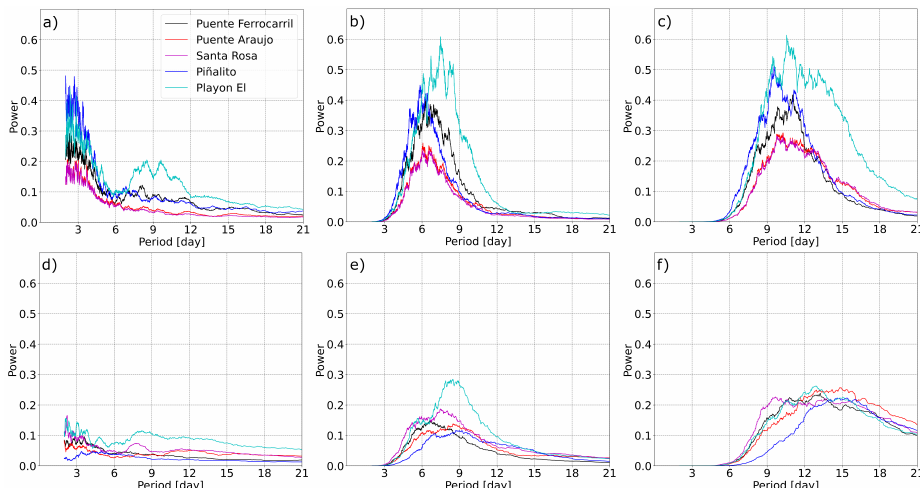
Figure 4. Fourier periodograms of precipitation and streamflows for the modes of synoptic variability according to the EEMD method in some catchments. ( top row ) IMFs for daily precipitation from ERA5 averaged over the catchment area. ( bottom row ) IMFs for daily streamflows. ( a , d ) IMF1, ( b , e ) IMF2, and ( c , f ) IMF3.